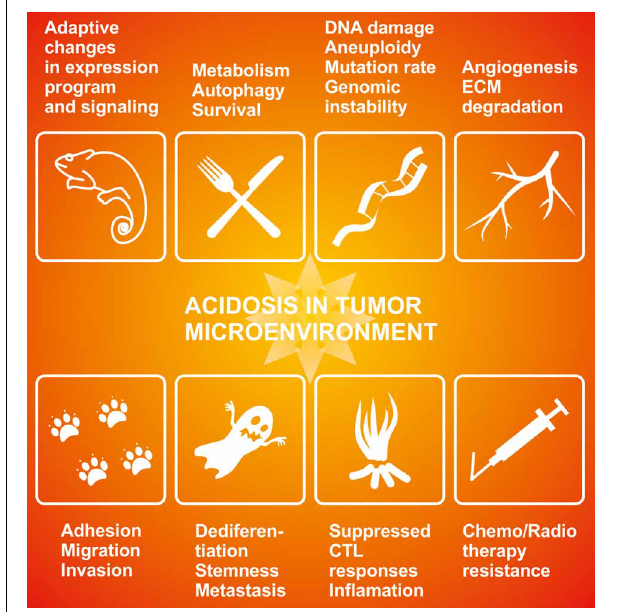
FIGURE 1 | The effects of acidosis on cancer-related phenomena. Acidosis in tumor microenvironment influences key aspects of tumor phenotype and cancer behavior including expression reprogramming and signal transduction (Putney and Barber, 2004; Chen et al., 2008;